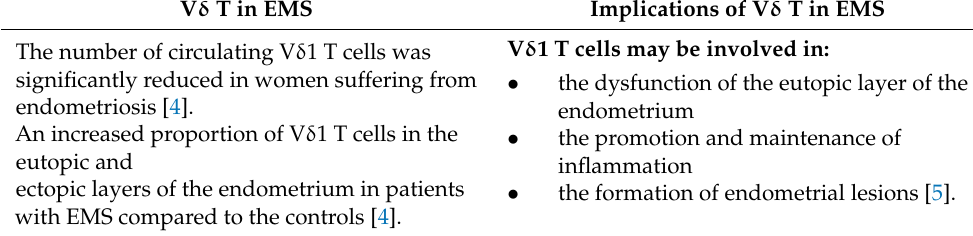
Table 1. The role of V δ T cells in the pathogenesis of endometriosis (EMS). V δ T in EMS Implications of V δ T in